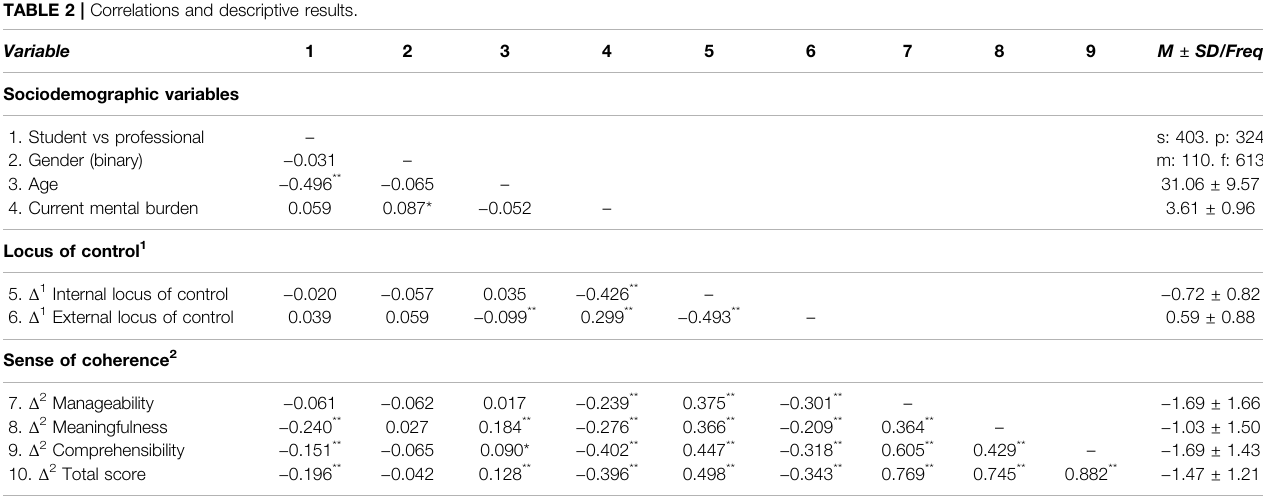
TABLE 2 | Correlations and descriptive